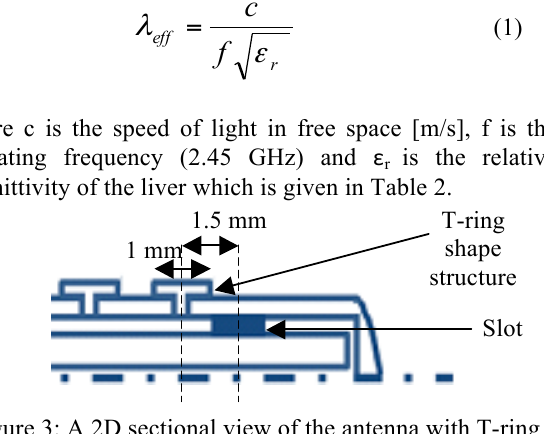
Figure 3: A 2D sectional view of the antenna with T-ring shape